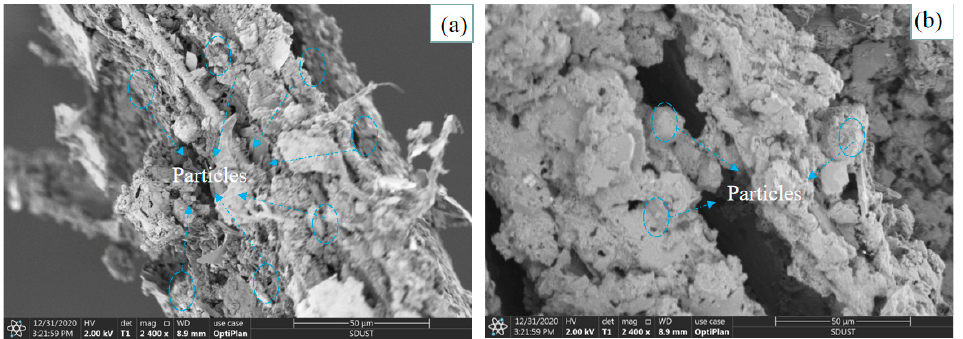
Figure 6. SEM micrographs of ( a ) cross-section of Rice straw fiber, ( b ) longitudinal section of straw fiber epidermis.